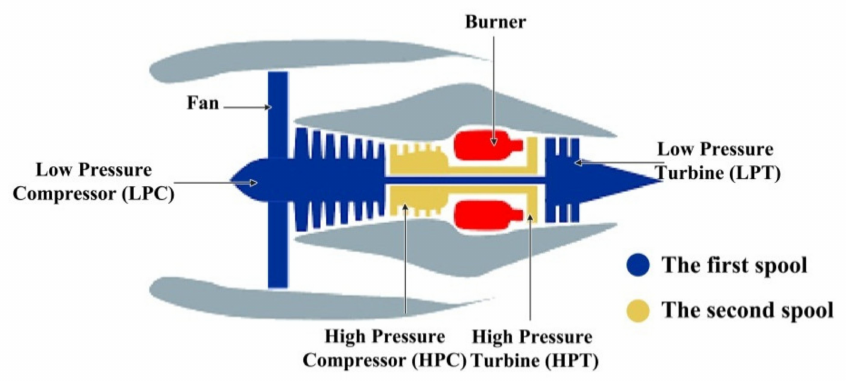
Figure 3. Studied turbofan type by C-MAPSS model.